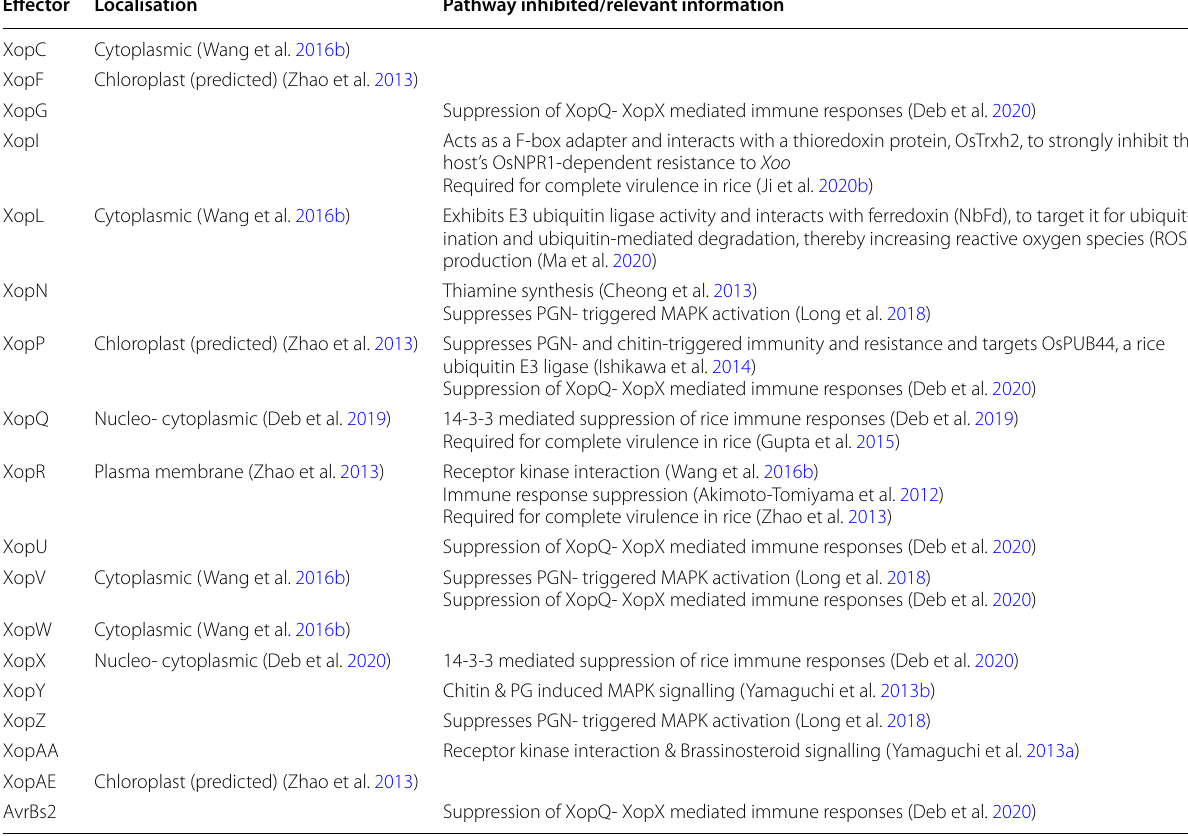
Table 2 Non-TAL effectors of Xoo Effector